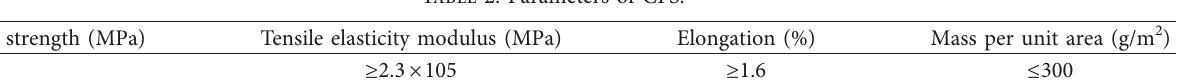
Table 2: Parameters of CFS.